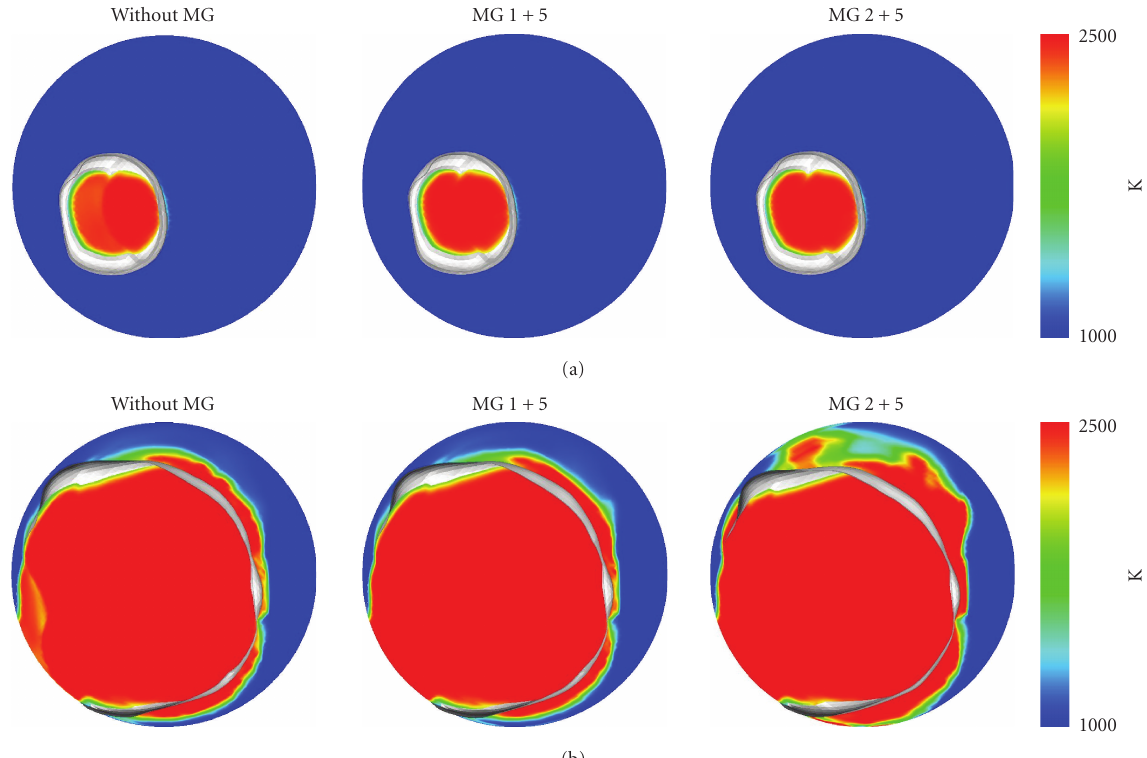
Figure 7: Iso-surface of flame front and temperature distribution at CA = 3 (a) and 18 (b) deg ATDC.